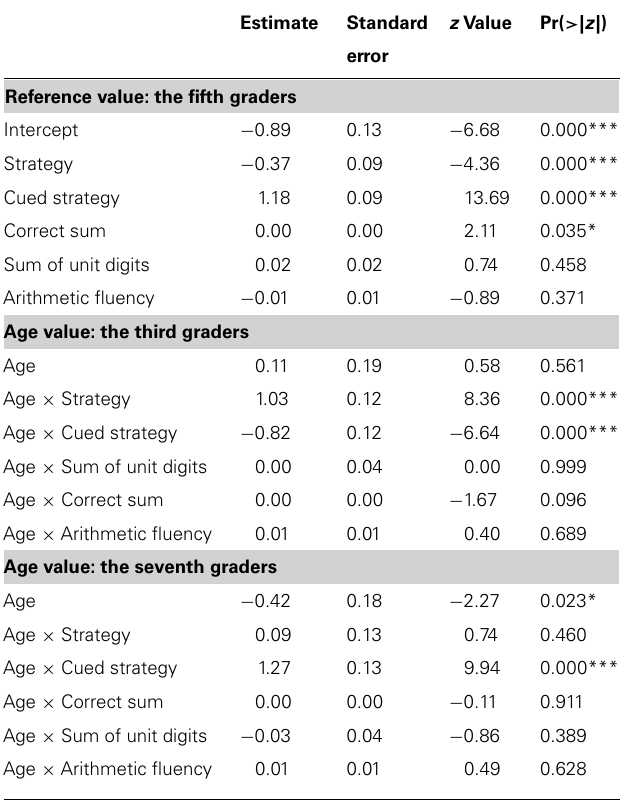
Table 3 | Linear mixed effect model